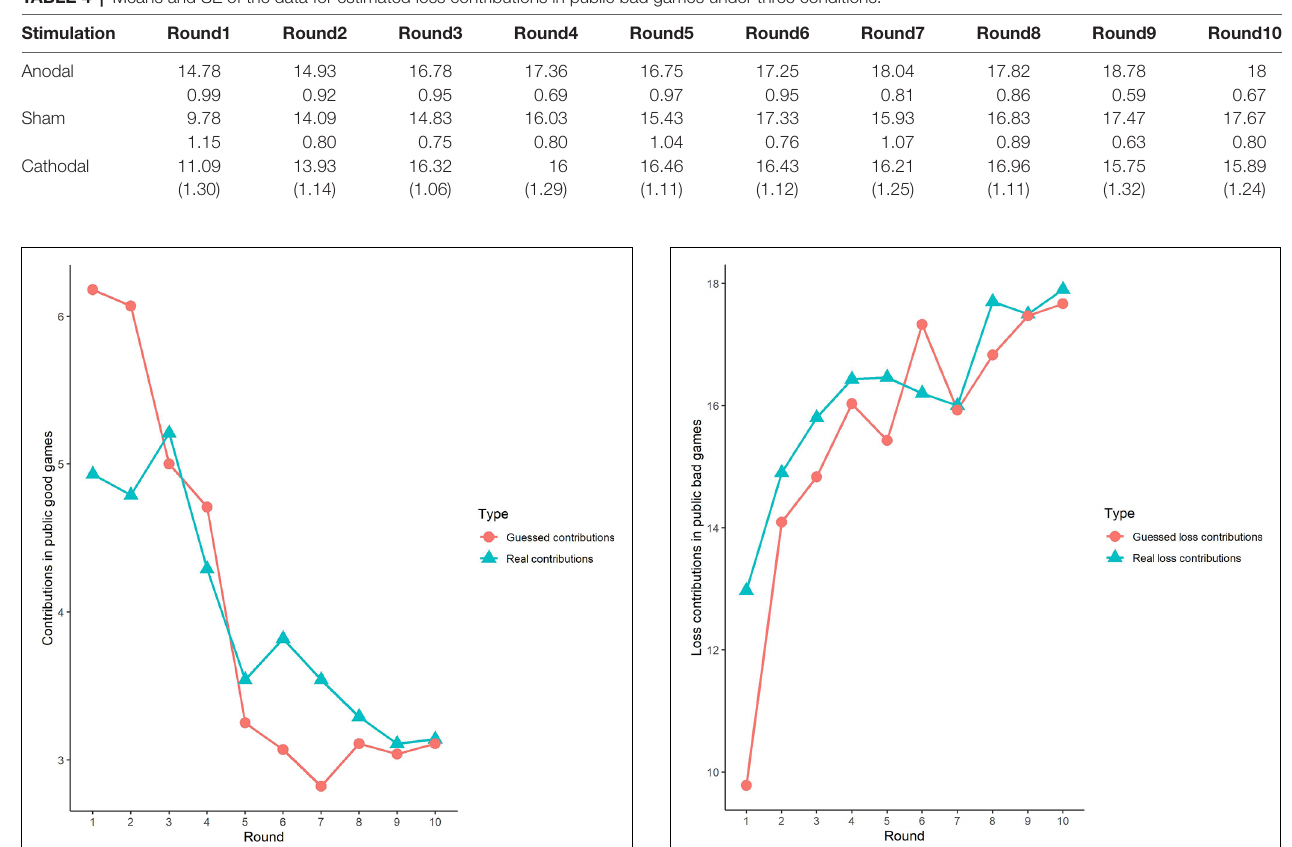
FIGURE 3 | Real contributions and guessed contributions by round in public good games.